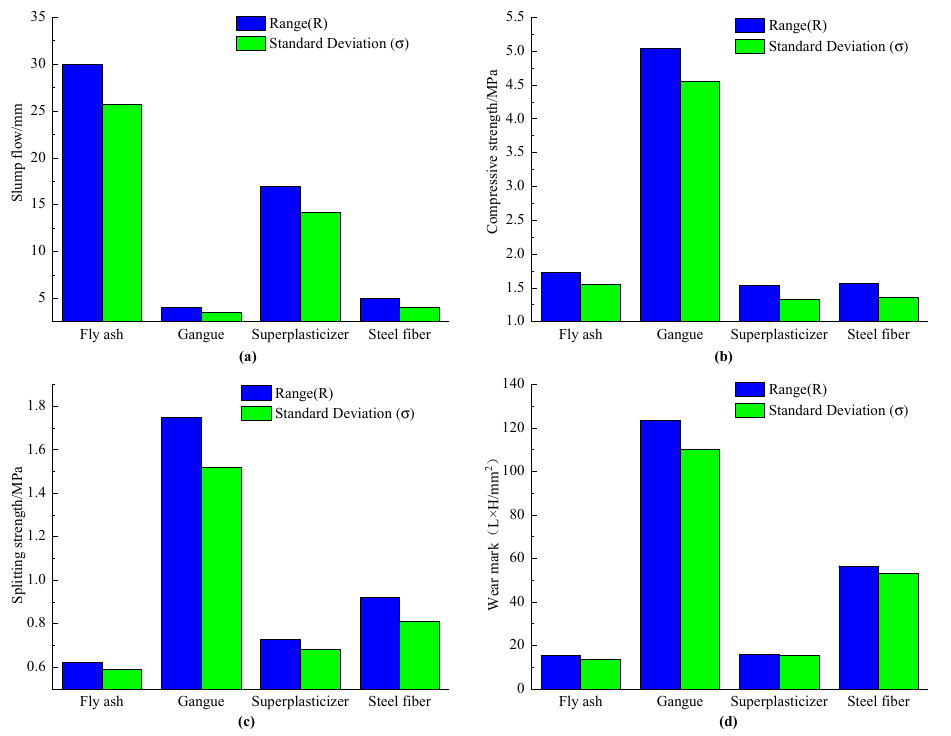
Figure 8. Range and standard-deviation results. ( a ) The influence of various factors on the slump flow of concrete. ( b ) The influence of various factors on the compressive strength of concrete. ( c ) The influence of various factors on the splitting strength of concrete. ( d ) The influence of various factors on the wear resistance of concrete.